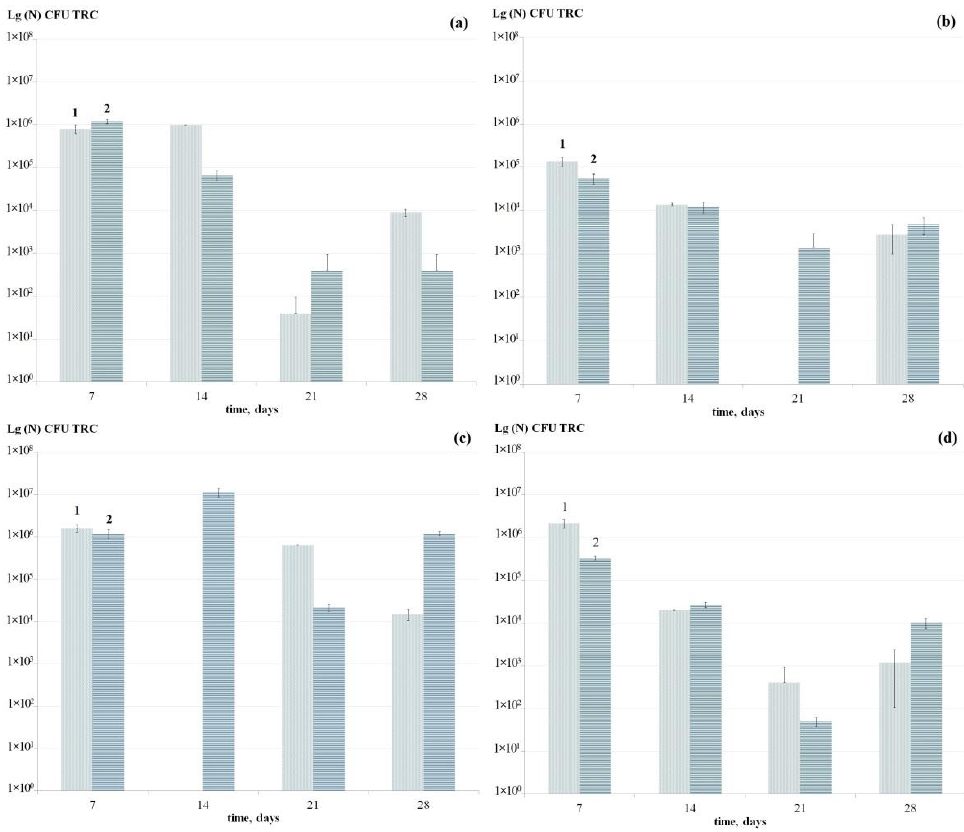
Figure 5. Dynamics of changes in the number (CFU/filter) of thermoresistant cells (TRC) in the biofilms (1) and planktonic cultures (2) of bacteria: E. coli ( a ), S. typhimurium ( b ), P. aeruginosa ( c ), S. aureus ( d ) during 28-day incubation.